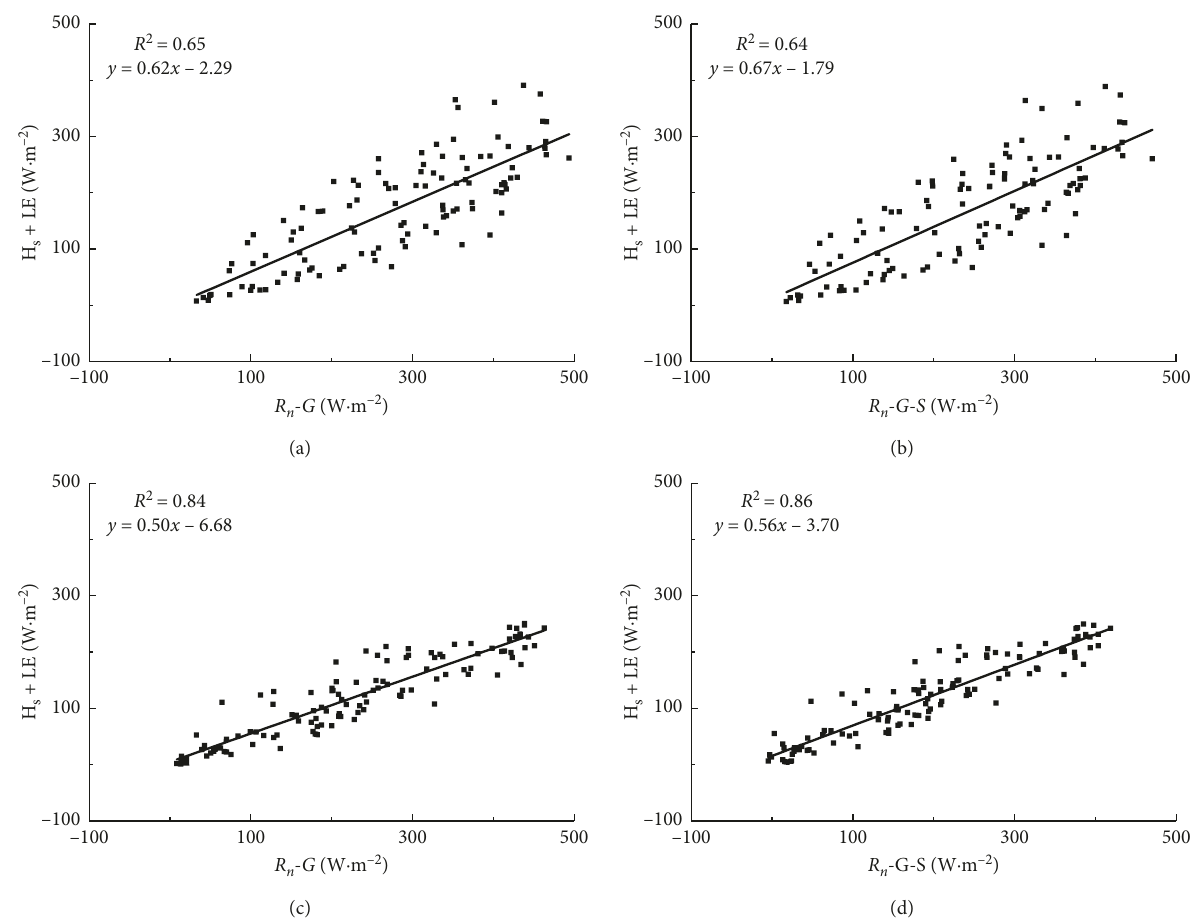
Figure 10: Variations in the EBR before and after rainfall: (a) without S before rainfall; (b) with S before rainfall; (c) without S after rainfall; (d) with S after rainfall.